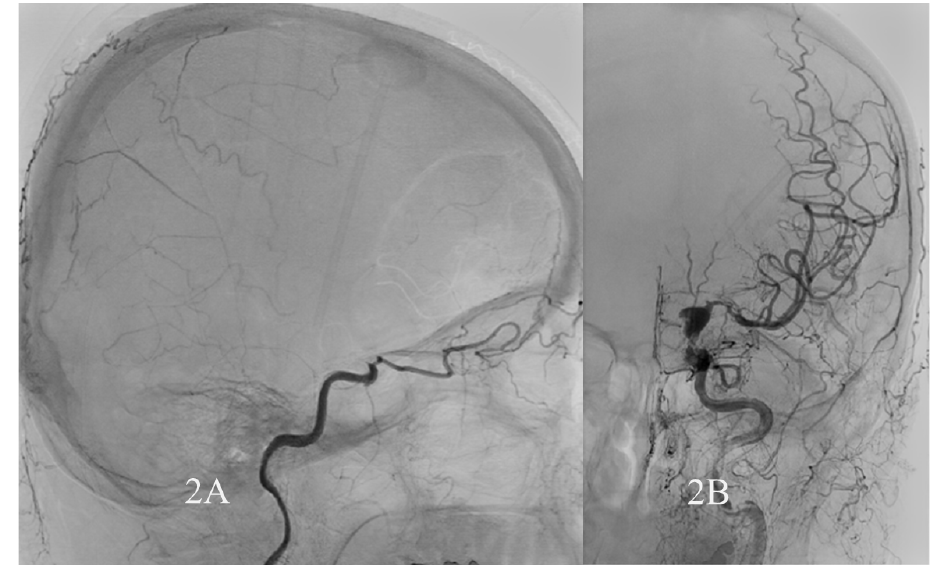
Fig. 2A. Angiogram of the left ICA proved its occlusion. B. Angiogram after 3 passes of the stent retriever. The flow was restored and an irregular fusiform aneurysm was revealed. There was also a stenosis of the M1 segment of the MCA and vasospasm on extracranial